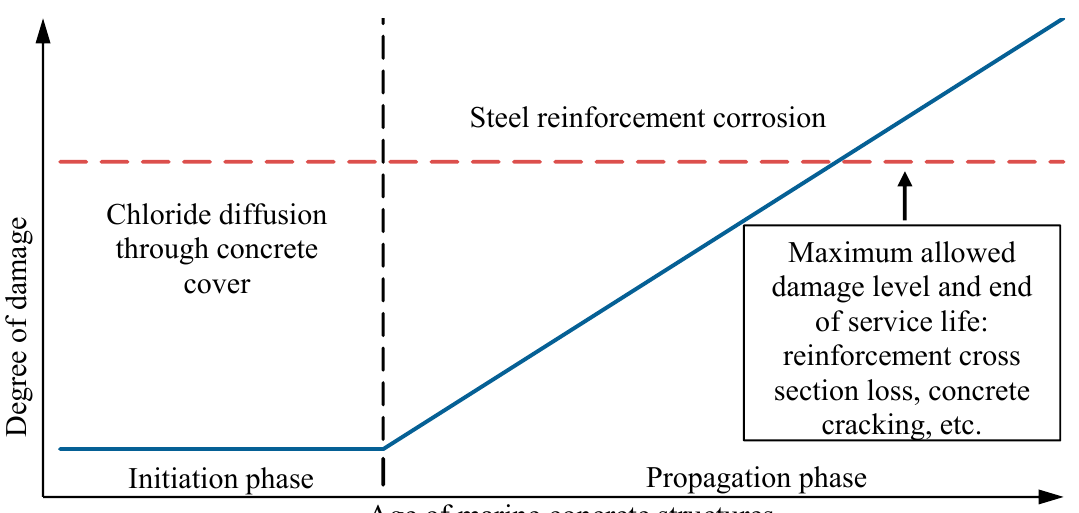
Figure 1. Chloride induced corrosion process of marine concrete structures (Adapted from [7]).